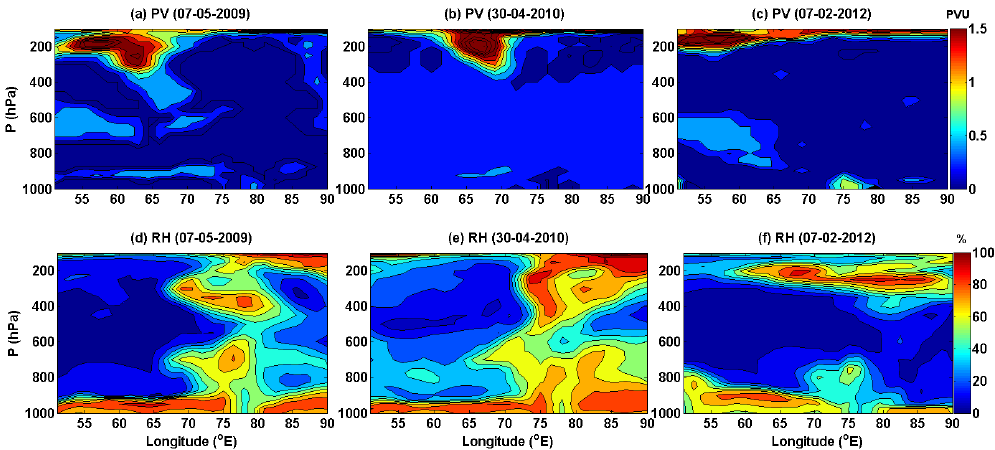
Figure 3. Longitude-height cross sections of PV (a–c) and RH (d–f) at 13.5 ◦ N for the days 7 May 2009, 30 April 2010 and 7 February 2012.